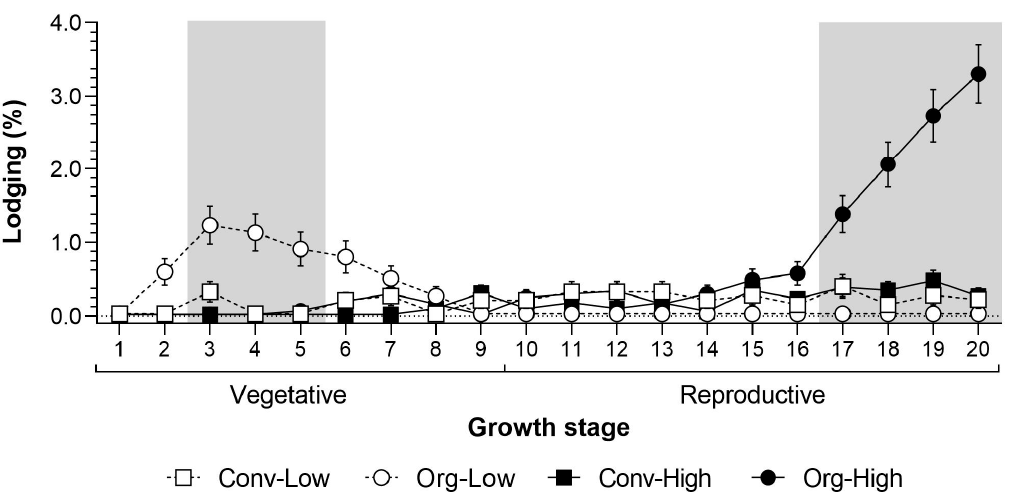
Figure 2. Lodging (% affected plants per plot and growth stage) in the experiment at Thika in the Central Highlands of Kenya. Grey areas show periods when there was a significant difference between the farming systems.